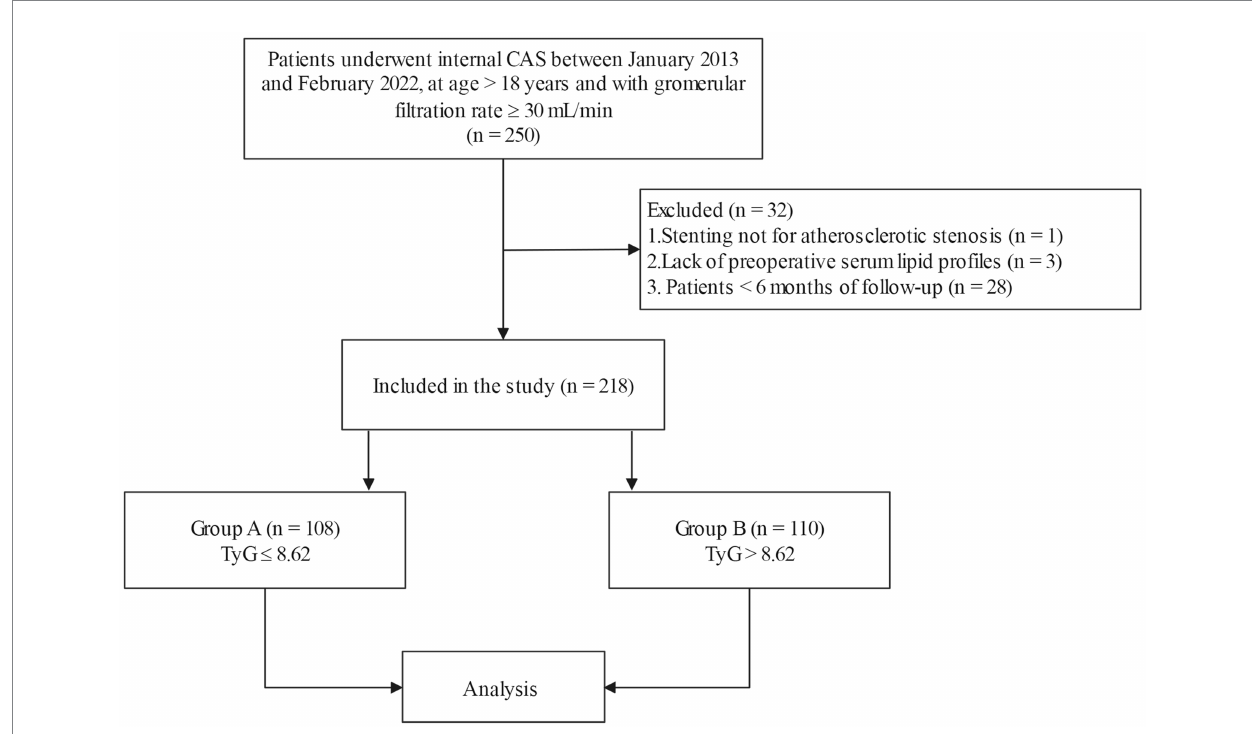
FIGURE 1 The flowchart of selection. CAS, carotid artery stenting; TyG,